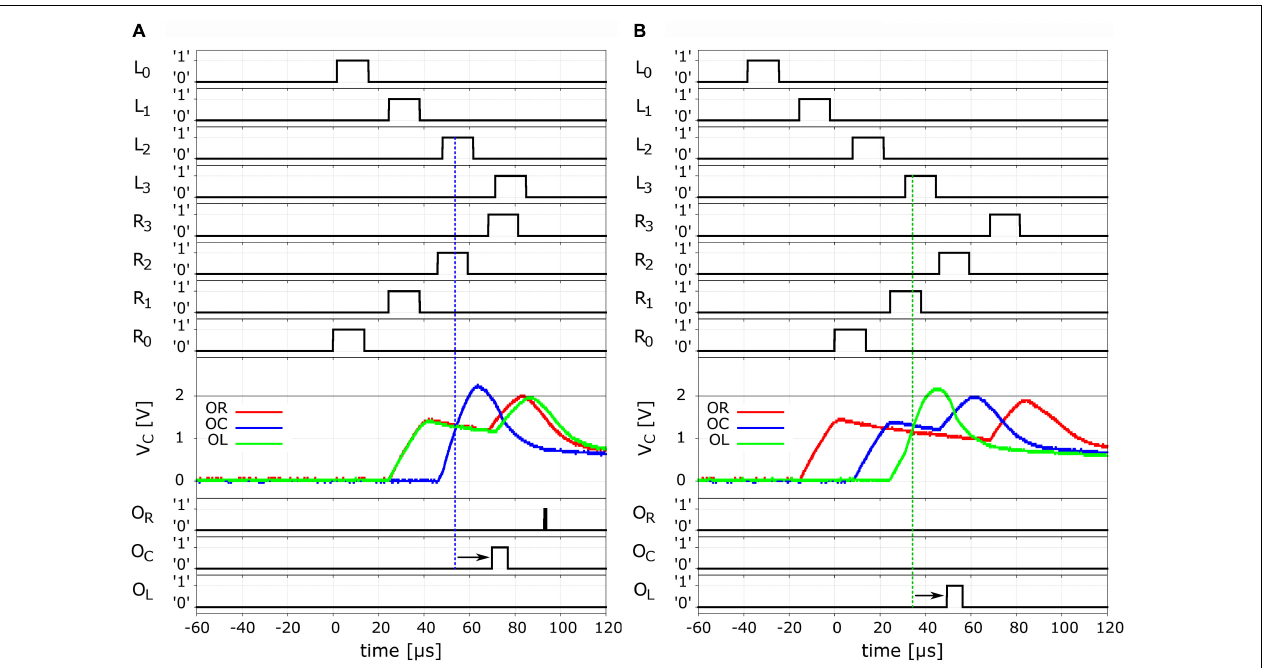
FIGURE 6 | Neurocomputation of ITD. Left panels (A) ITD = 0 µ s and right panels (B) ITD = 40 µ s. Top four rows show the traces of the propagation of the spikes along the right-ear delay line, from R0 to R3, measured at the respective unit outputs. The next four lines show the respective signals for the spikes propagating in the left-ear delay line, in opposite direction. The mid panel show the membrane voltage VC for the three output neurons. As expected for the symmetric case of ITD = 0 µ s ( α = 0), we observe the build-up of the potential of the central neuron OC (blue). When this membrane potential overcomes the threshold it sets off an output spike as can be seen in the trace of the output neurons in the last three rows, where we indicated an additional delay by the small arrows. The right hand panels have the respective traces for the case of a finite ITD = 40 µ s, where we observe that the coincidence was detected by the OL neuron (green).